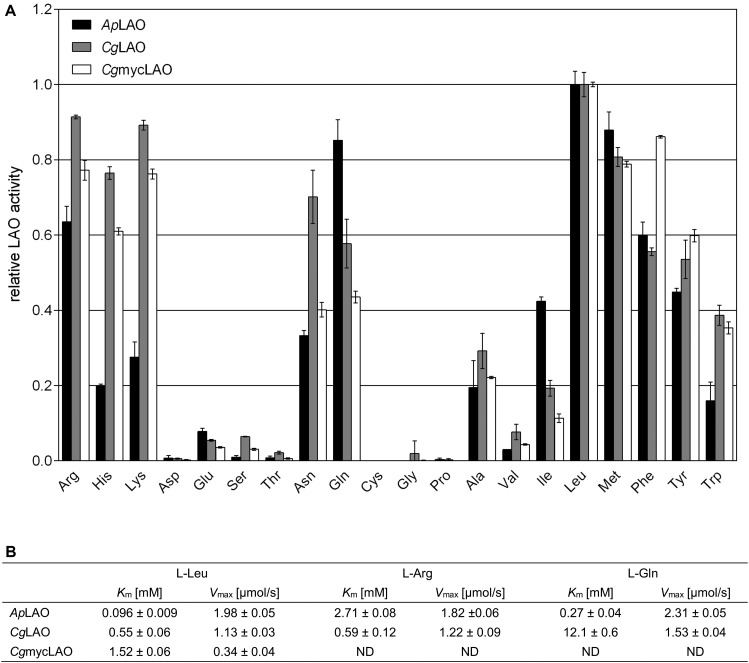
Substrate specificities and kinetic properties of ApLAO, CgLAO and CgmycLAO. (A) Quantitative analysis of different L-amino acid substrates (5 mM) at pH 7.5 and 37°C. Data are means ± standard deviation normalized to L-Leu, the optimal substrate for both enzymes. (B) Km and Vmax were determined experimentally and using Michaelis-Menten equation.